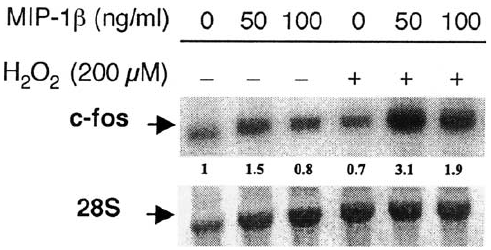
FIG. 9. Effect of H 2 O 2 on MIP-1 b -induced c-fos expression. Monocytes were treated with either medium or 200 m M of H 2 O 2 for 4 h in serum-free medium. The medium was then replaced by new medium and the cells were incubated for 16 h at 37 8 C. MIP-1 b or medium were then added for 20 min and total RNA was extracted for northern blot analysis. The autoradiogram of one experiment representative of two independent experiments is